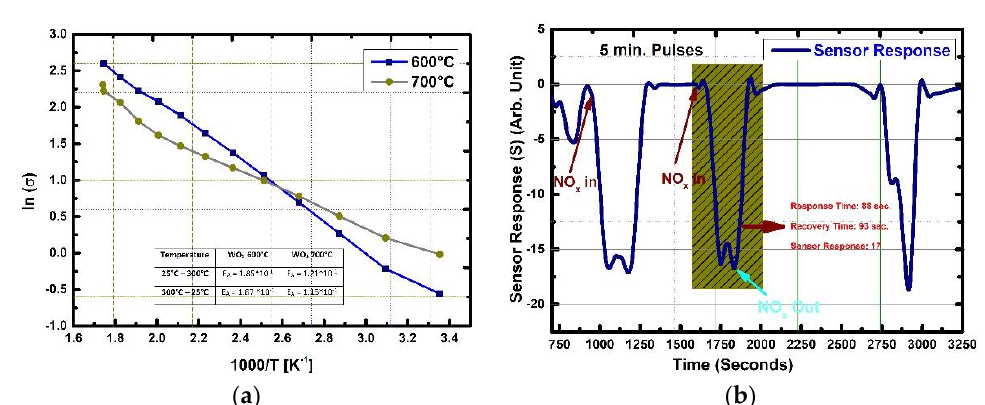
Figure 4. ( a ) Electrical conductivity as a function of the reciprocal of the temperature (1000 / T) for CVD deposited WO 3 thin films. The inset Table shows the activation energy values for WO 3 thin films. ( b ) 600 ◦ C deposited CVD WO 3 thin film chemical sensor response curves as a function of gas concentration and time varying exposure times of 2.5 ppm of NO